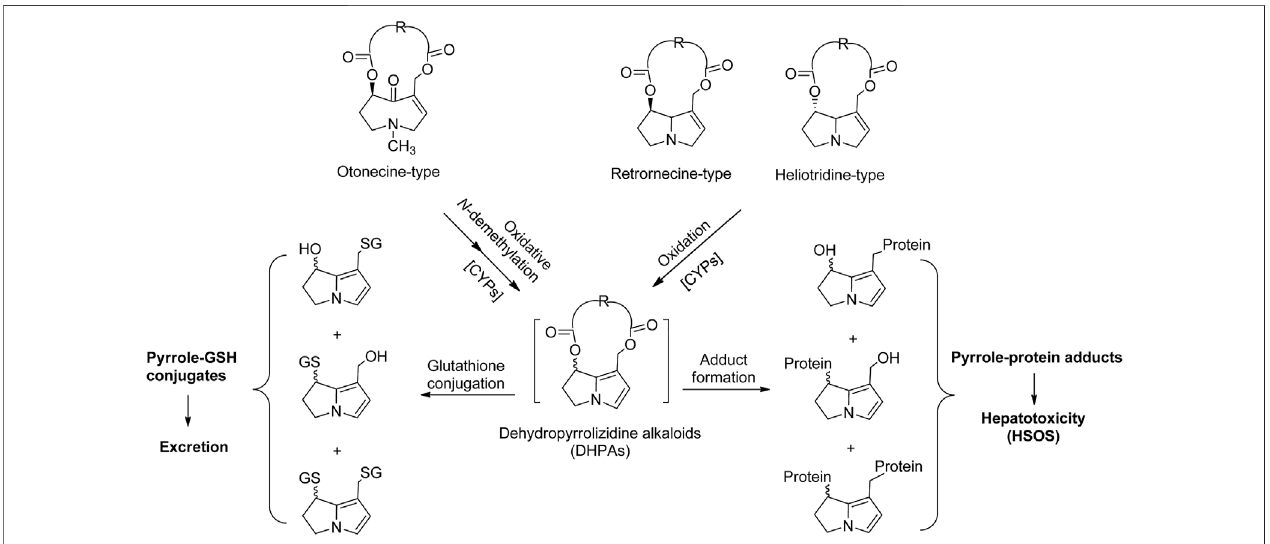
FIGURE 1 | The scheme of hepatic metabolic activation of retronecine-, heliotridine-, and otonecine-type PAs to form dehydropyrrolizidine alkaloids (DHPAs), which either bind with glutathione as a detoxi fi cation pathway, or interact with proteins to generate pyrrole-protein adducts, leading to liver damage.